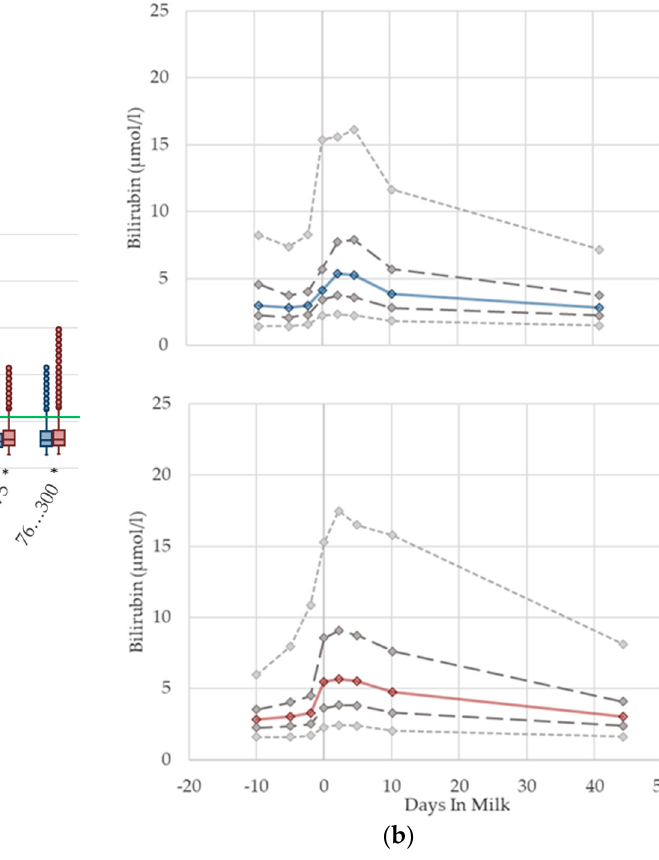
Figure 3. Serum concentrations of bilirubin in primiparous (blue) and in multiparous (red) cows ( a ) in 10 classes between 30 days prepartum to 300 days postpartum (boxplots), green continuous lines represent the reference values according to Fürll [23], asterisk indicates significant differences regarding parity within DIM class; and ( b ) in 8 classes from 10 days prepartum to 40 days postpartum (median—continuous line; 1st and 3rd quartile—dashed lines; percentile 5 and 95—dotted lines).